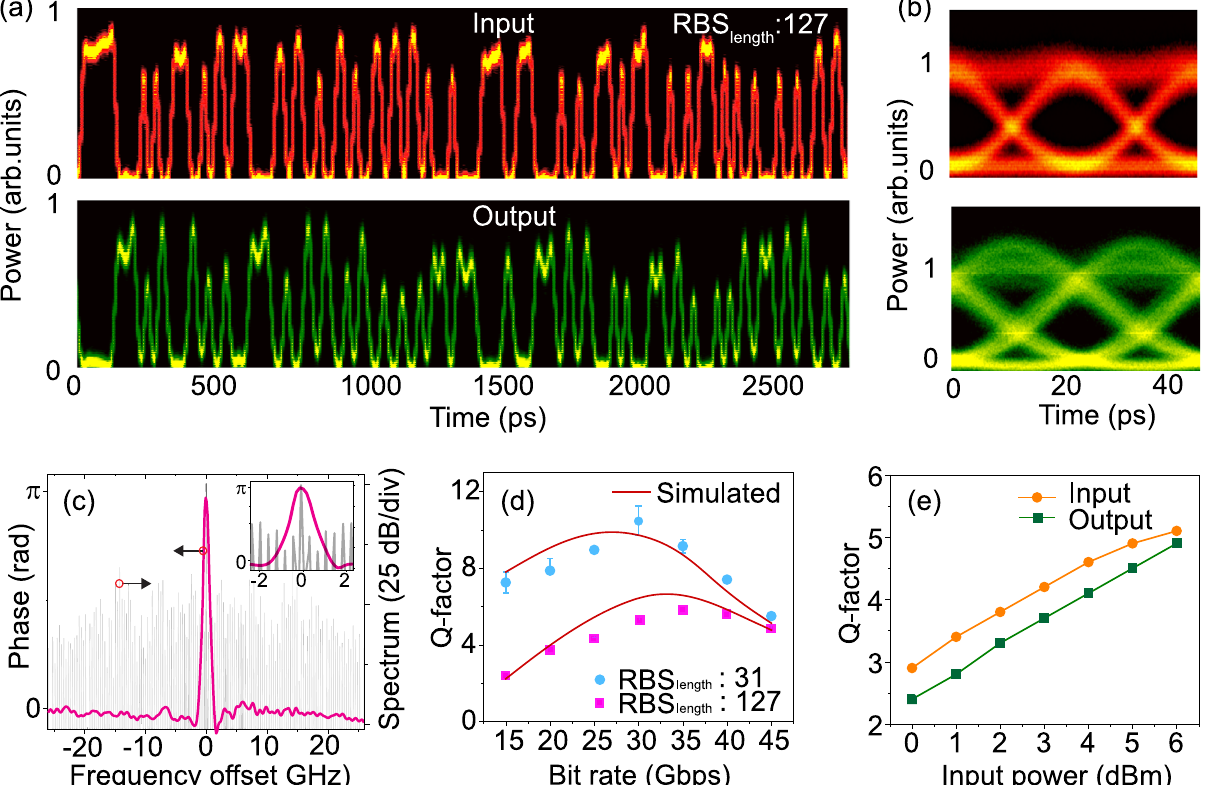
Fig. 2 | Experimental results related to NOT operation of NRZ-OOK signals using the phase fi lter. a Measured temporal waveforms atthe input (top) and the output (bottom) of the phase fi lter. The input is a 45-Gbps NRZ-OOK signal with a random bit sequence (RBS) of 127 bits, centred at ~1550 nm wavelength. Temporal waveforms are recorded using an optical sampling oscilloscope (OSO). b Corresponding eye diagrams over a single bitperiod. c Measured spectral phase responseofthephase fi ltersuperimposedwiththemeasuredspectrumoftheinput 45-Gbps NRZ-OOK, 127-bit RBS signal. The inset shows the zoomed-in π − phase